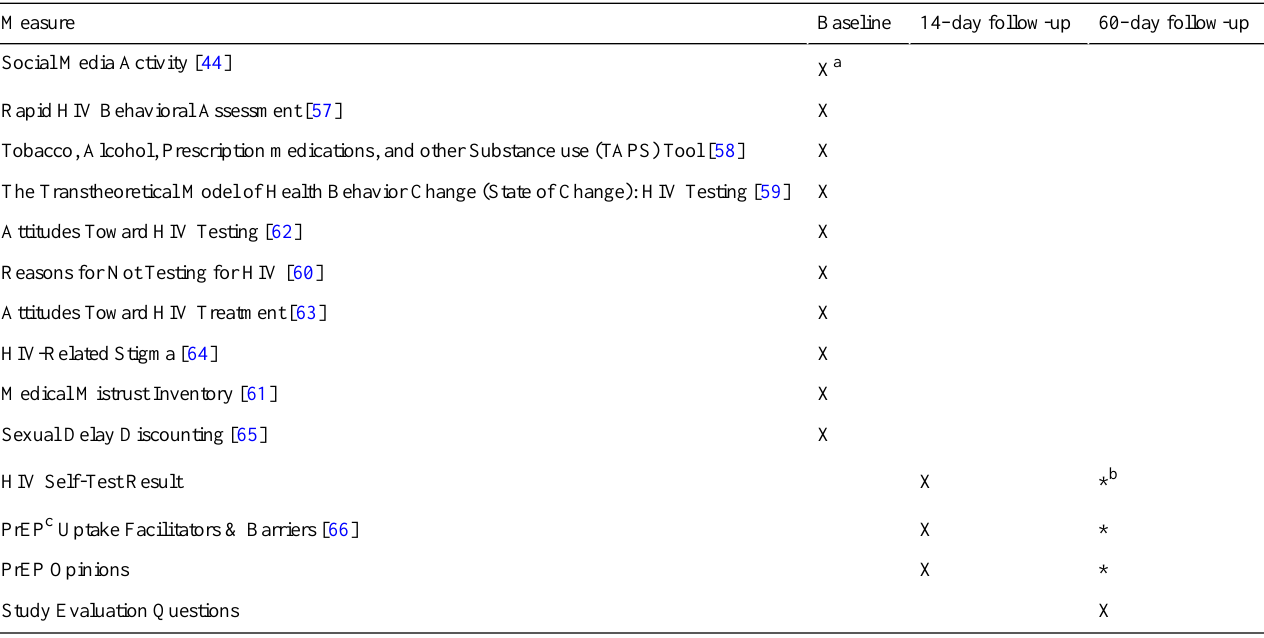
Table 2. HIV self-test study schedule of study